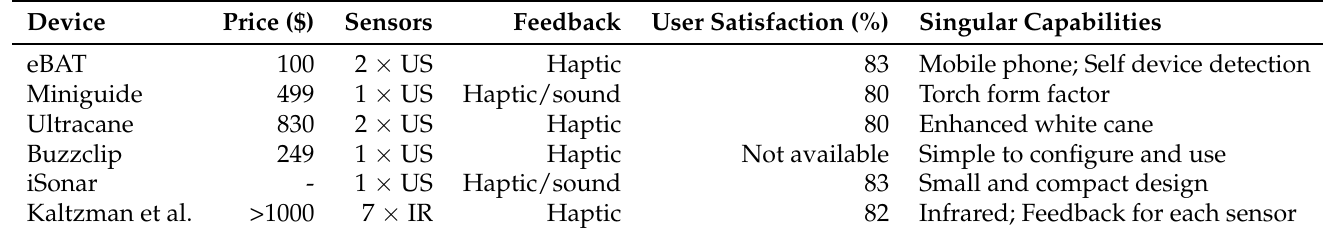
Table 5. Comparison of the eBAT with other